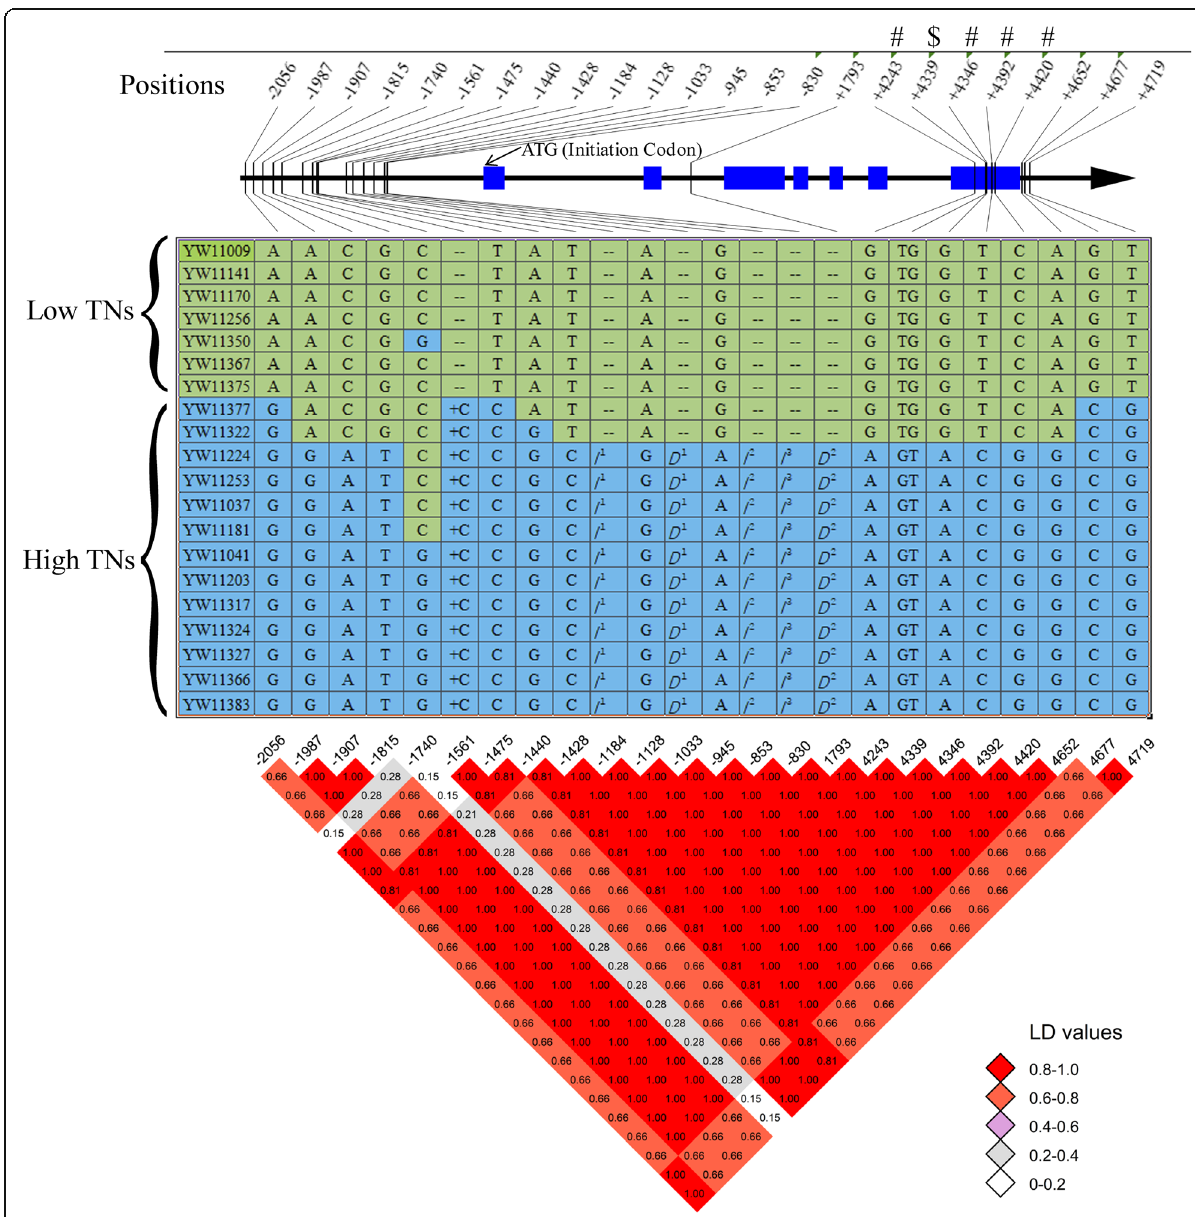
Fig. 3 Sequence analysis of the candidate gene Os01g28690 in the rice accessions with extremely low and high TNs. Tilted numbers at the top represent the position related to the initiation codon of ‘ ATG ’ ; ‘ - ’ indicates upstream of ‘ ATG ’ ; ‘ + ’ indicates downstream of ‘ ATG ’ ; “ # ” is a synonymous mutation; “ $ ” indicates a missense mutation from tryptophan (W) to Valine (V). Arrow shows the direction of Os01g28690 ; blue rectangles indicate the gene exon regions. The middle panel is the detail sequence variation among the extreme low and high TN accessions. ‘ A ’ , ‘ T ’ , ‘ G ’ and ‘ C ’ in the table are the bases. ‘ -- ’ indicates that the sequence in the accessions is the same as the reference sequence, and “ +C ” indicates insertion of one base pare. ‘ I 1 ’ , ‘ I 2 ’ and ‘ I 3 ’ represent insertion of ‘ ATTACTAG ’ , ‘ CTCGCGGA ’ and ‘ CCTTCG ’ , respectively, while ‘ D 1 ’ and ‘ D 2 ’ represent deletion of ‘ ATGTTATCAATTTGACAACATGGC ’ and ‘ ATCT ’ , respectively. The bottom panel is the LD-decay of the TN variation in the region. The LD values are included in the blocks with different